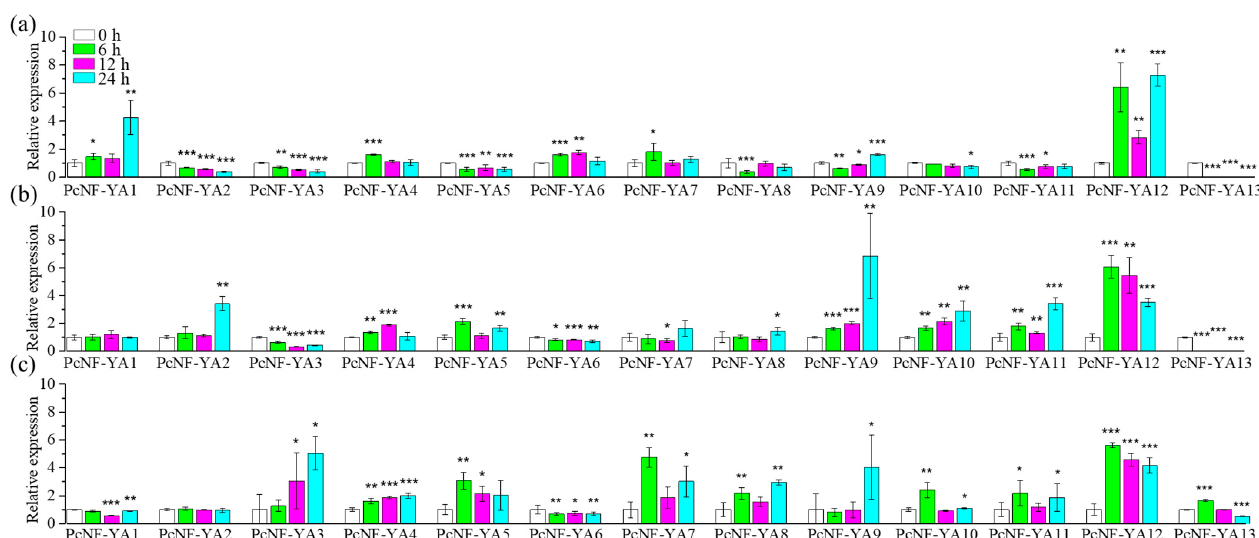
Figure 6. Expression pattern analysis of PcNF-YA genes under different nitrogen form treatments at different times by RT– qPCR. ( a ) Expression profile analysis of the PcNF-YA genes at different times under nitrate treatment; ( b ) Expression profile analysis of the PcNF-YA genes at different times under ammonium nitrate treatment; ( c ) Expression profile analysis of the PcNF-YA genes at different times under ammonium treatment. The data are expressed as the mean ± SD ( n = 3). P -values from one-way ANOVA for the different times are indicated: *: p < 0.05; **: p < 0.01; ***: p < 0.001.